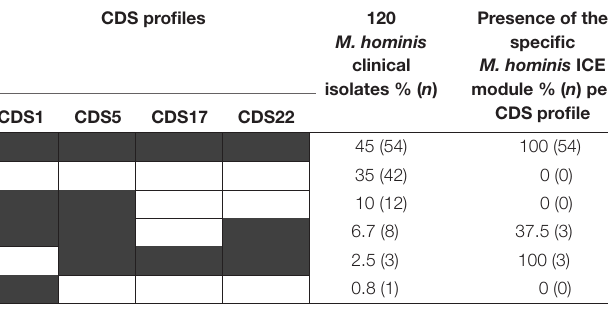
TABLE 6 | Distribution of the four ICE backbone CDSs and the specific M. hominis ICE module in 120 clinical isolates of M. hominis. CDS